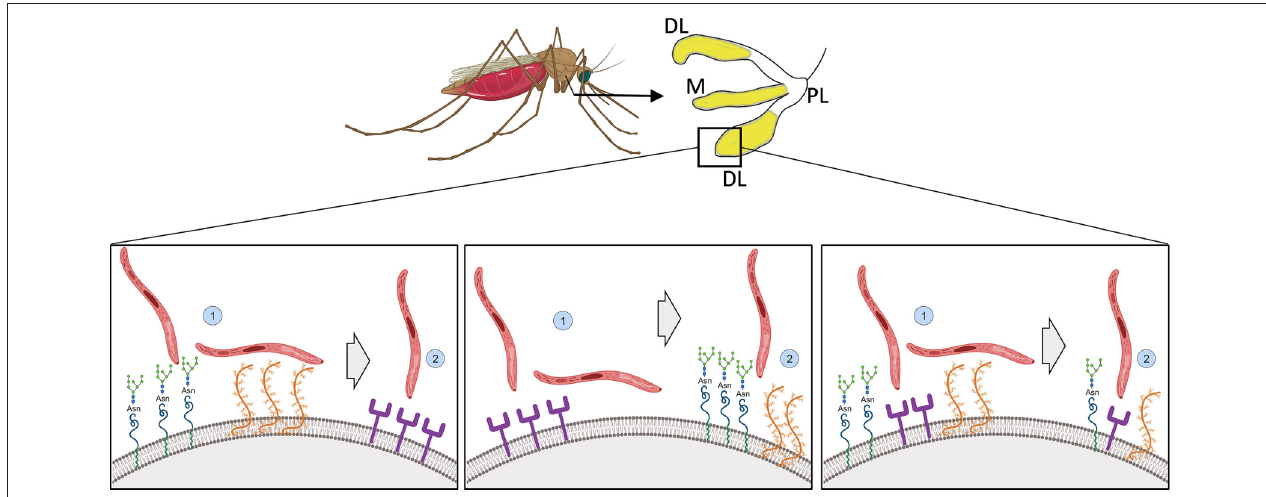
FIGURE 2 | Illustration of possible modes of sporozoite recognition, attachment and invasion of mosquito salivary glands. Sporozoites preferentially invade the distal lateral and medial lobes of mosquito salivary glands (in yellow). How molecules on the salivary gland surface interact with the sporozoite to allow penetration is not known. (Left) Sporozoites recognize and attach to the salivary gland via glycoproteins and proteoglycans and invasion would be completed via protein based receptors. (Middle) Alternatively, the opposite would occur, with the recognition and attachment being done by protein based receptors and the invasion by the glycoproteins and proteoglycans. (Right) Both sugar and peptide-based motifs would be responsible together for recognition, attachment and invasion. Created with Biorender.com.